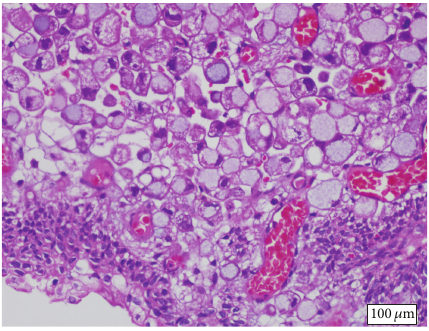
Figure 2: Signet-ring cell carcinoma infiltrating bladder subepithe- lium (H&E, ×